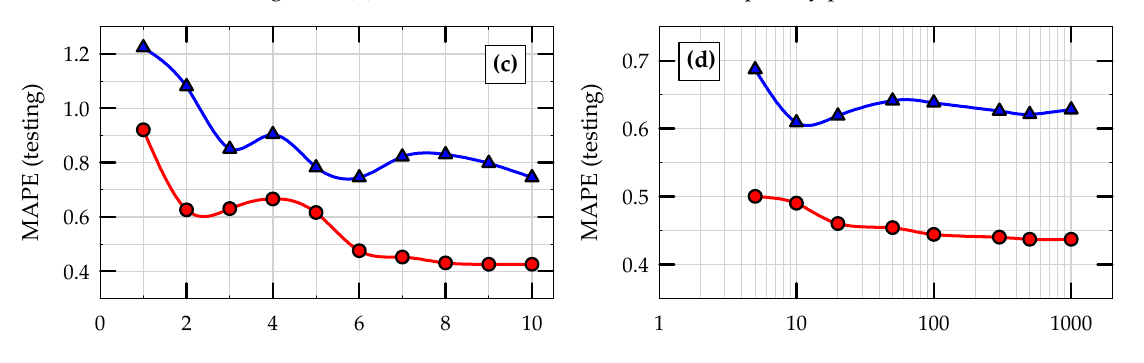
both θ peak and FS TO . Any value smaller than the optimum for k would overfit the training